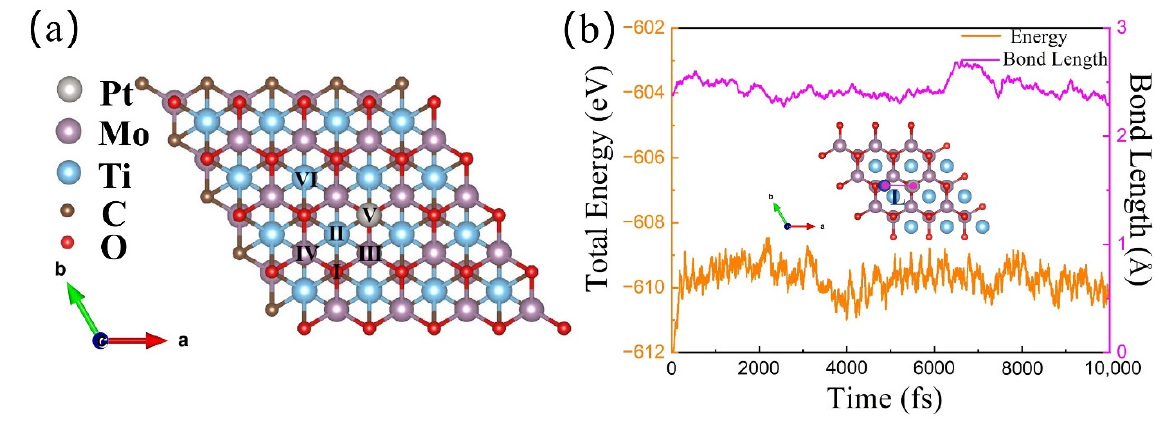
Figure 2. ( a ) The schematic diagrams of the TM atomic possible adsorption sites on the surface of Pt@Mo 2 TiC 2 O 2 (TM = Sc, Ti, V, Cr, Fe, Co, Ni, Cu, and Zn), i.e., Site I, Site II, Site III, Site IV, Site V, and Site VI. ( b ) The evolution of bond length (L) between Cu and Pt atoms and the total energy for Pt/Cu@Mo 2 TiC 2 O 2 h-DACs within 10,000 fs in AIMD simulations performed at 300 K. a, b and c are the three directional axes of the cell structure, respectively.